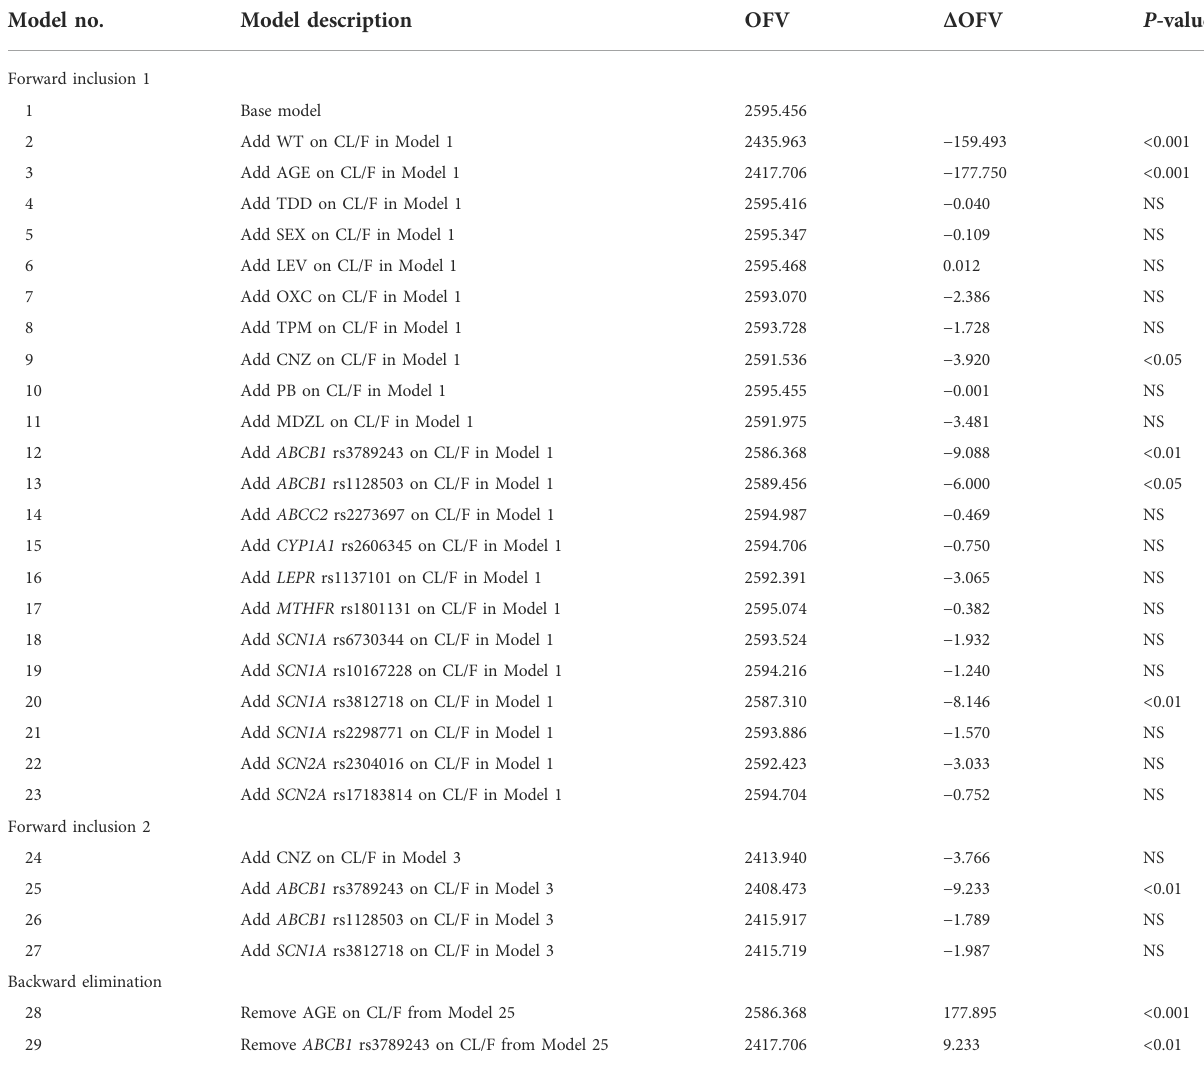
TABLE 3 Results of hypothesis testing in the model development procedure. Model